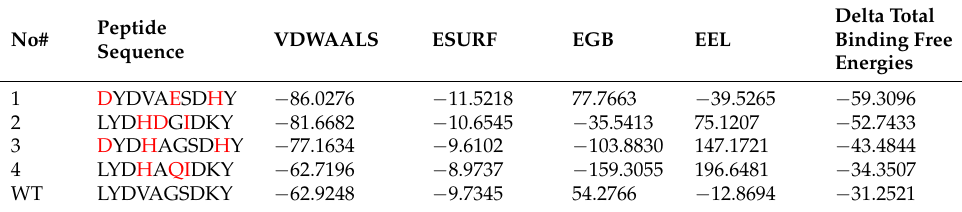
Figure 4. ( A – D ) RG (radius of gyration) of all the systems was calculated from the 0–200 ns MD simulations trajectory. The x -axis shows the number of frames and the y -axis shows RG in Angstrom. This figure represents the superposed plot for radius of gyration (Rg) in reference peptide and designed peptides mutants in complex with the K-Ras mutant. The reference peptide/K-Ras mutant complex is shown in red while the ( A ) (S. No 1) L175D-G180E-K183H peptide/K-Ras system, ( B ) (S. No 2) V178H-A179D-S181I peptide/K-Ras system, ( C ) (S. No 3) L175D-V178H-K183H/K-Ras system, ( D ) (S. No 4) V178H-G180Q-S181I/K-Ras complex are shown in cyan, olive green, yellow, and purple, respectively. Table 2. The MMGBSA Binding free energy (kcal/mol) calculation for refpeptide/ K-Ras complex and its variants (1–4 designed